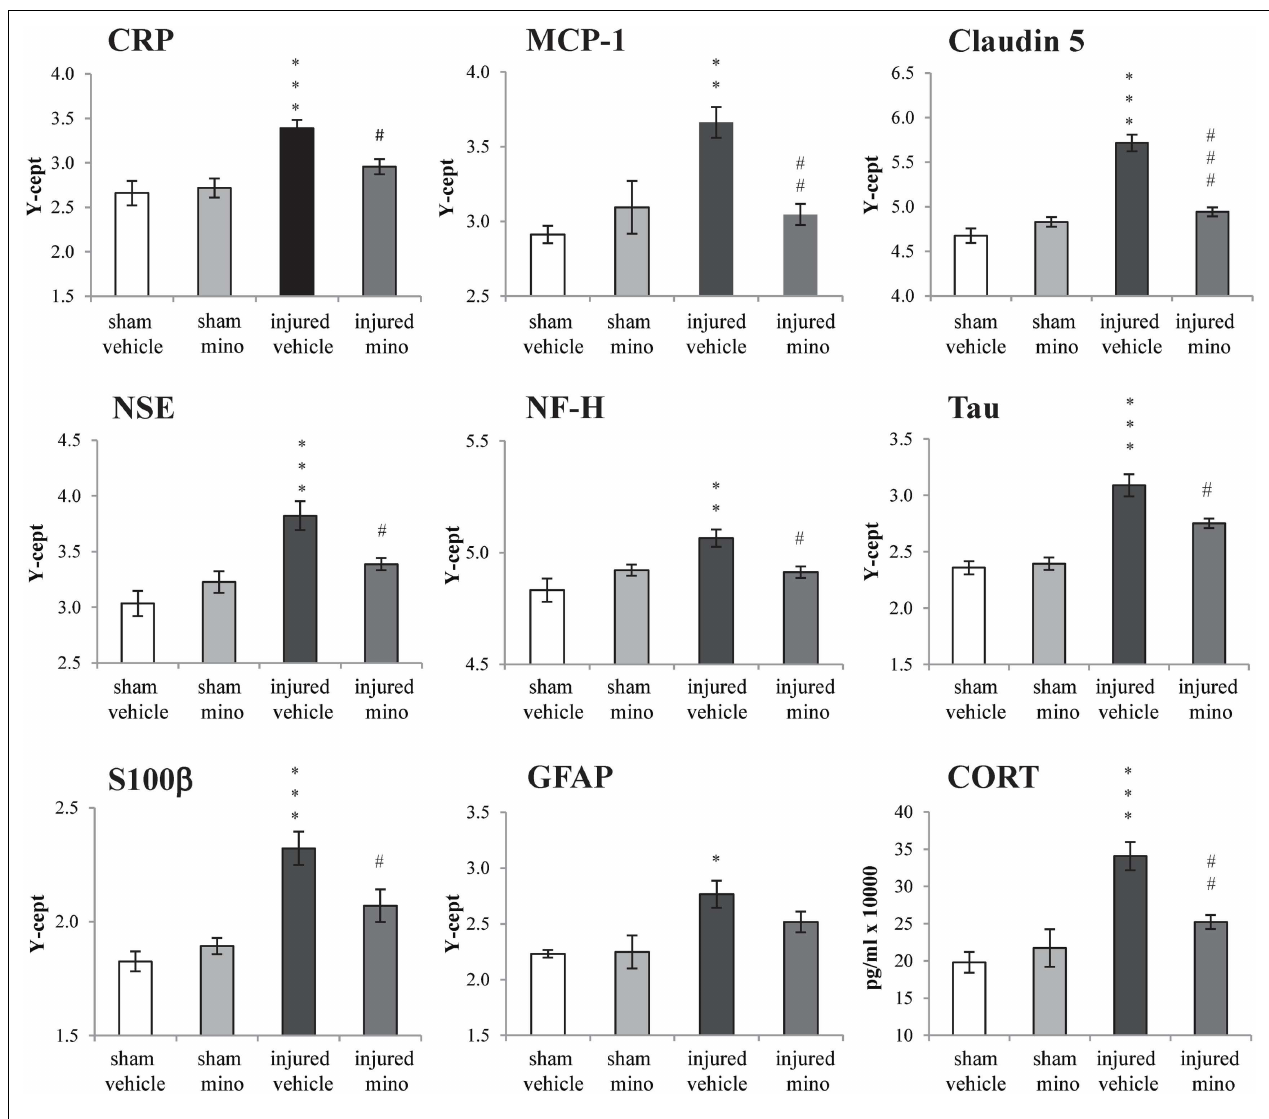
and CORT values are expressed as pg/ml. Data are presented as mean ± SEM. * p < 0.05, ** p < 0.01, and *** p < 0.001 for injured-vehicle